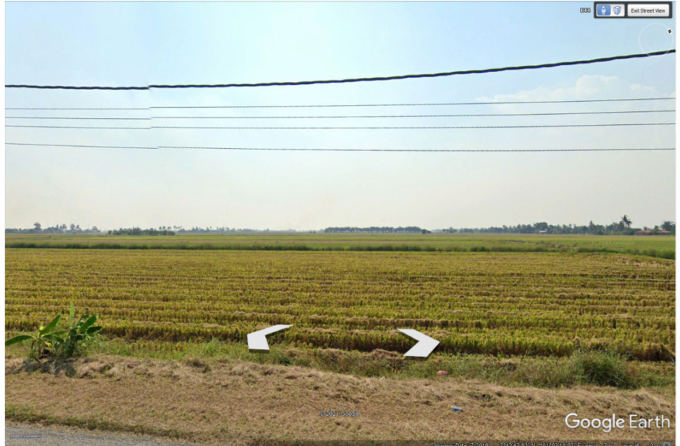
Figure 4. Accuracy assessment by using a street view image from Google Earth in Sungai Besar, Selangor state (3 ◦ 42 (cid:48) 43.92 (cid:48)(cid:48) N, 101 ◦ 03 (cid:48) 10.93 (cid:48)(cid:48) E) in July